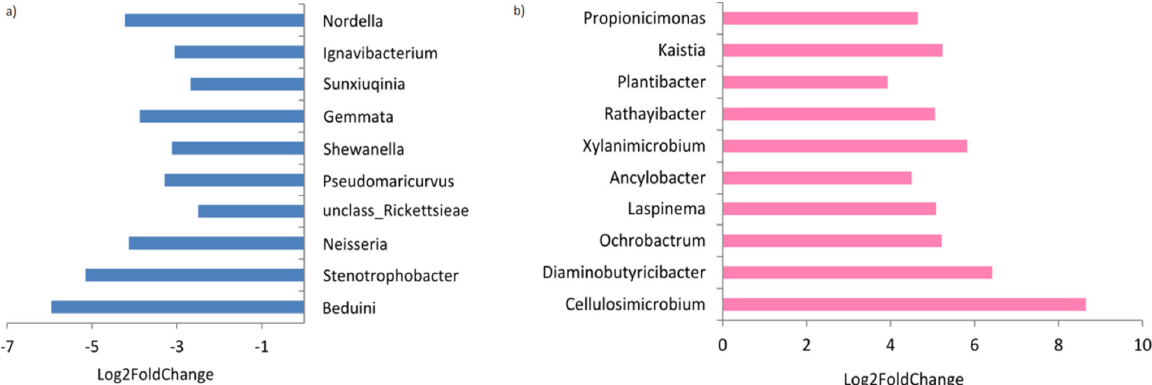
Figure 3. Average fold changes in the genera, with different abundances in the midgut of both the T0 and EPN ‐ resistant groups of A. solstitiale larvae. ( a ) Negative changes, ( b ) positive changes ( p < 0.05).